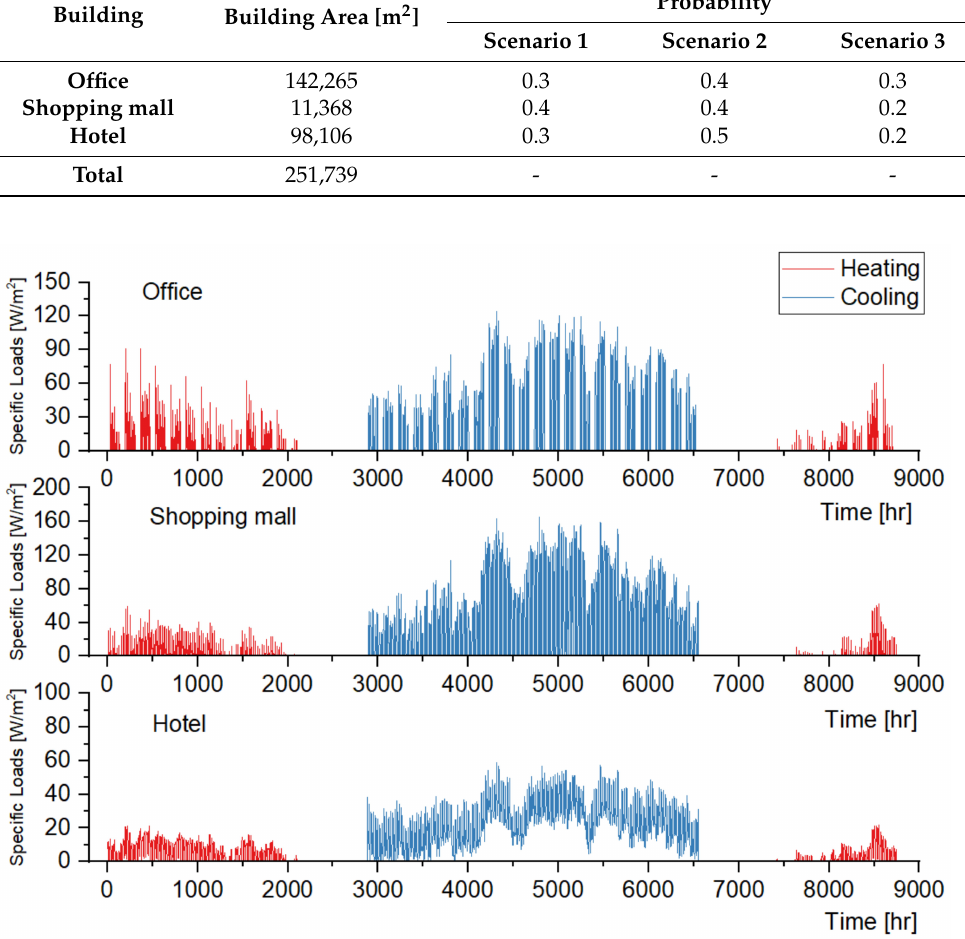
Figure 21. Predicted hourly specific cooling and heating loads of three types of